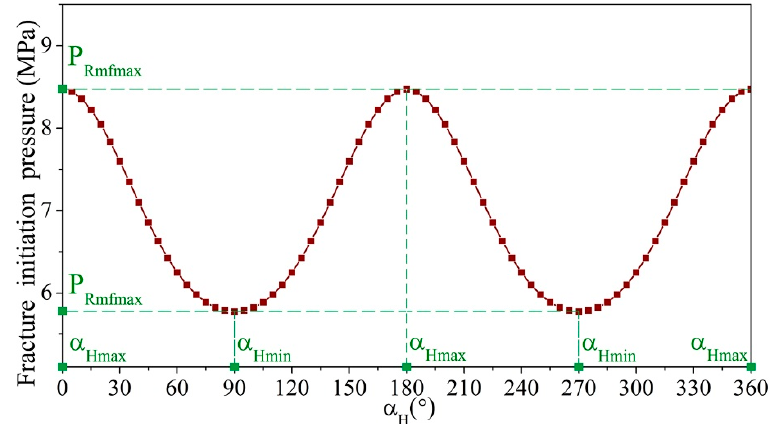
Figure 6. Variation in fracture initiation pressure at the point θ = 0° or 180° on the wellbore of the intact rock matrix with drilling direction.